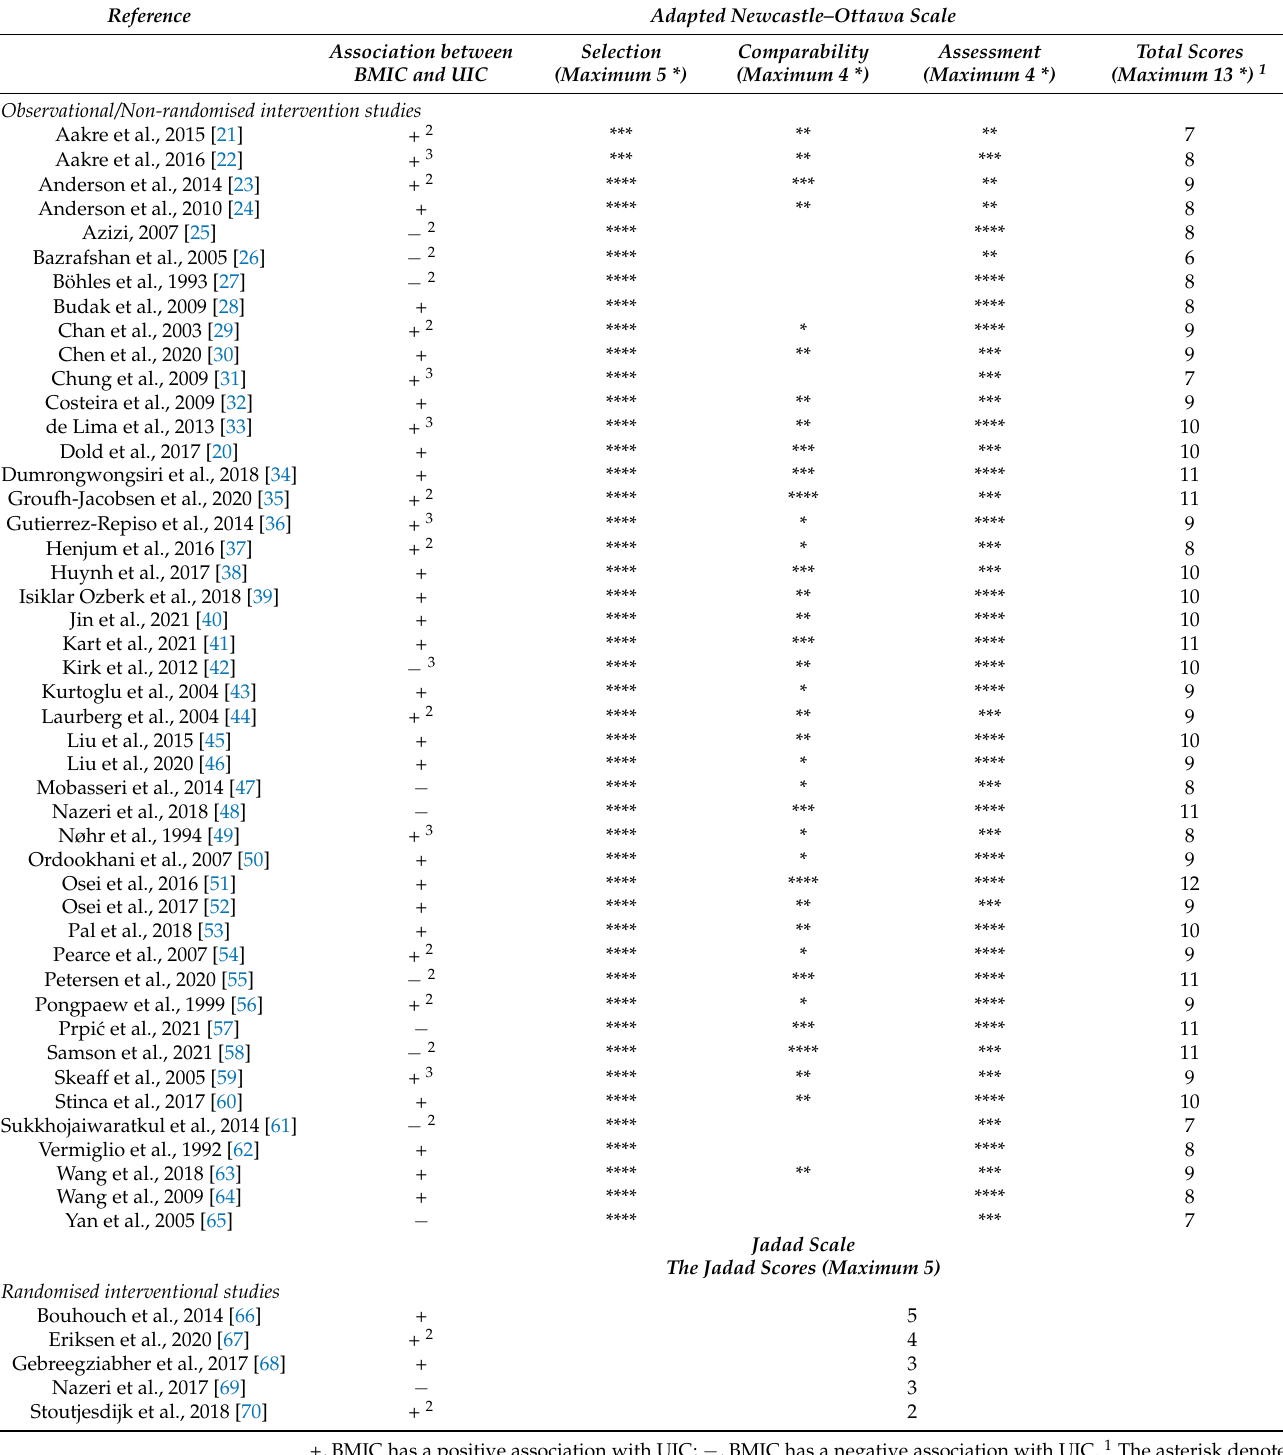
Table 1. Summary of the association between BMIC and UIC and study scores for quality